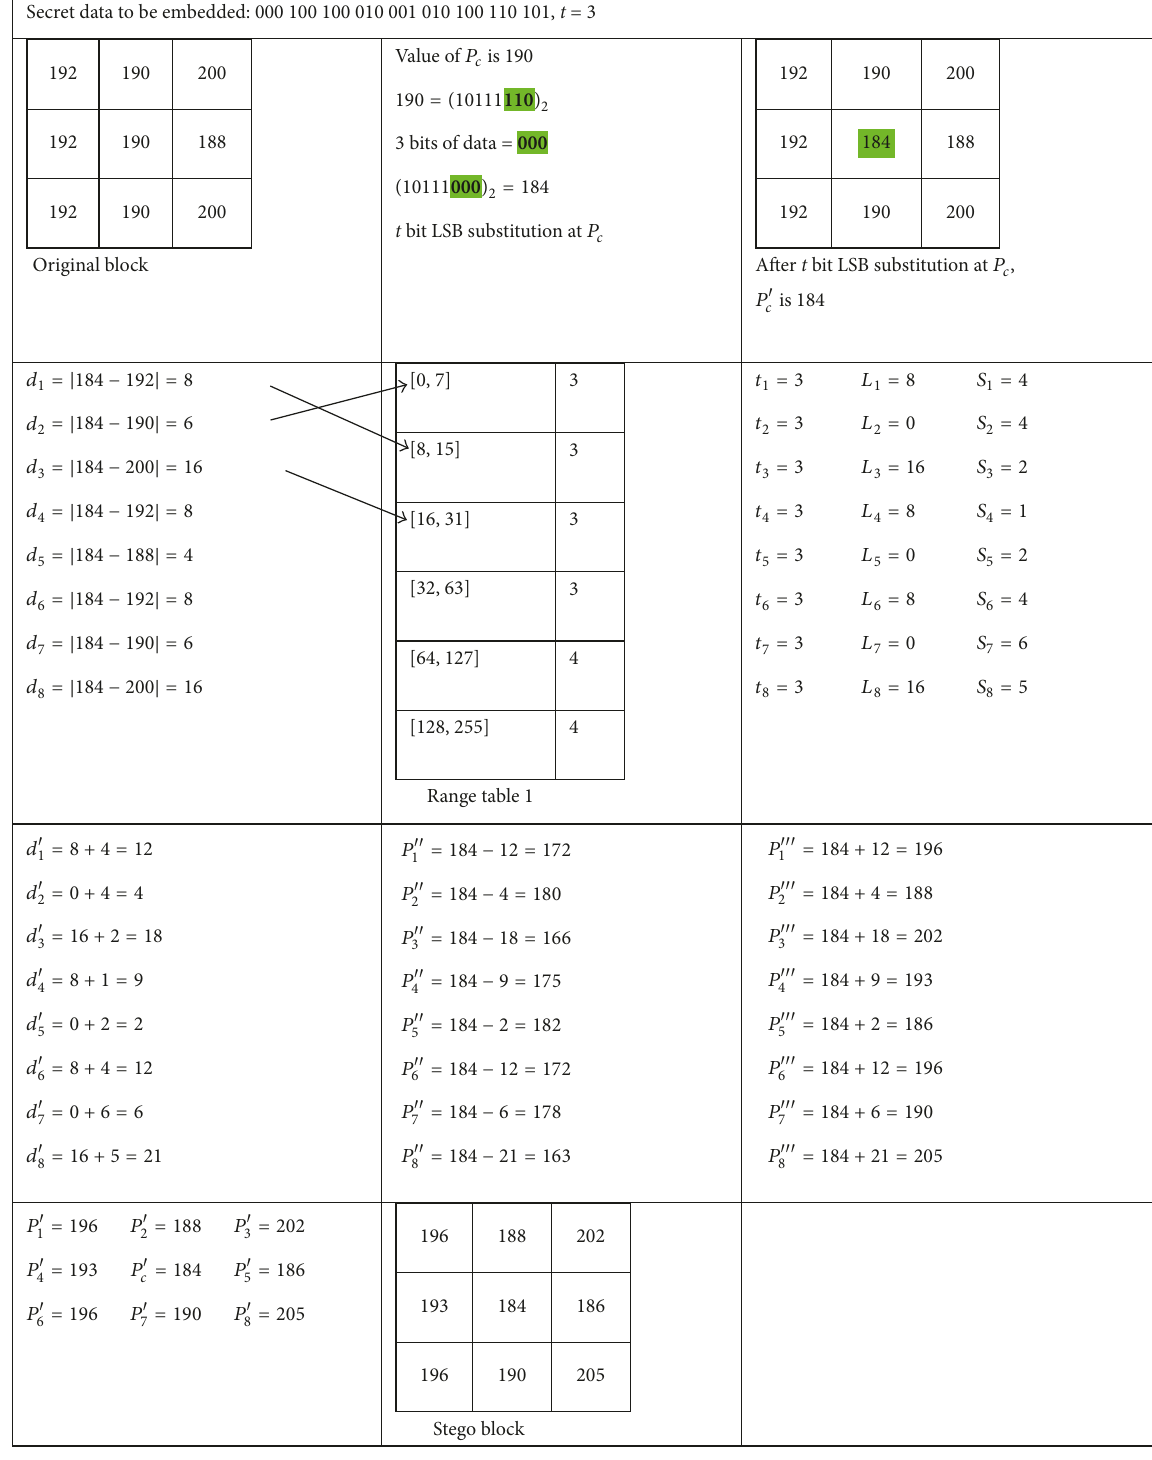
Figure 2: Example of